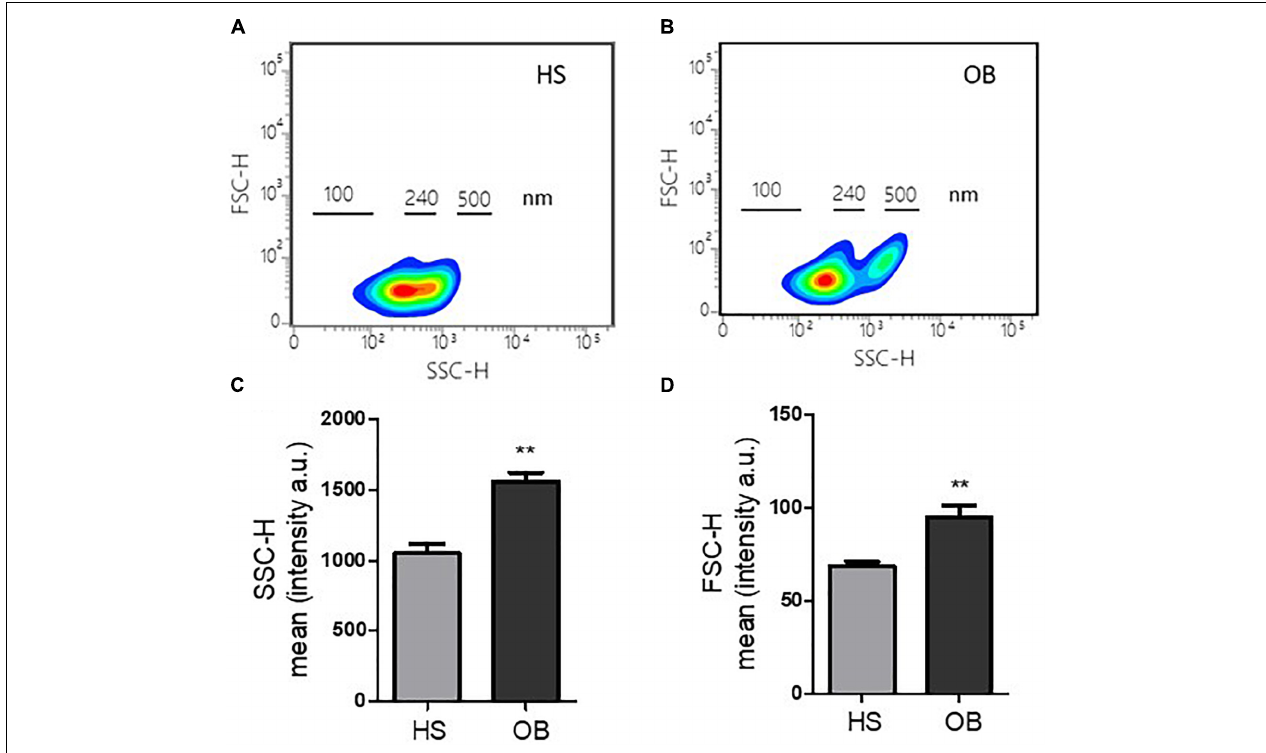
FIGURE 1 | Features of MPs released from platelets of obese and non-obese women. (A,B) Density plots of forward scatter height (FSC-H) vs. side scatter height (SSC-H) of a typical MP suspension from non-obese (HS) and obese (OB) individuals, and size distribution. (C,D) Fluorescence intensity of FSC-H and SSC-H parameters reported as arbitrary unit (a.u.) ( n = 4 for each group); ∗∗ P < 0.01 vs. HS.